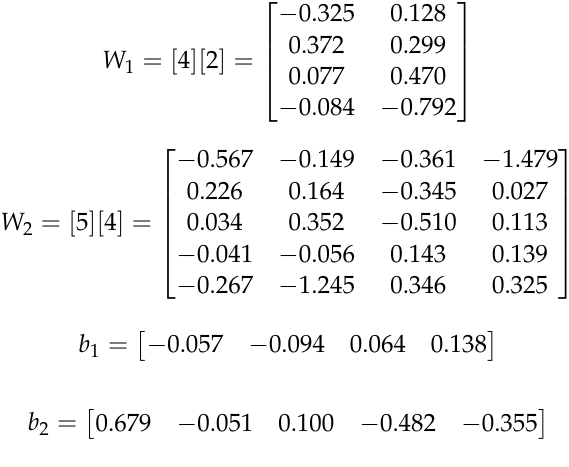
Figure 17. Graph of the trend of the neural network accuracy with new data (train loss) and the trend of the loss function (val loss). Relation of the precision of the neural network after 3000 epochs. Values obtained from the synaptic weights W and the polarization vectors b of the two neurons, after 3000 epochs: